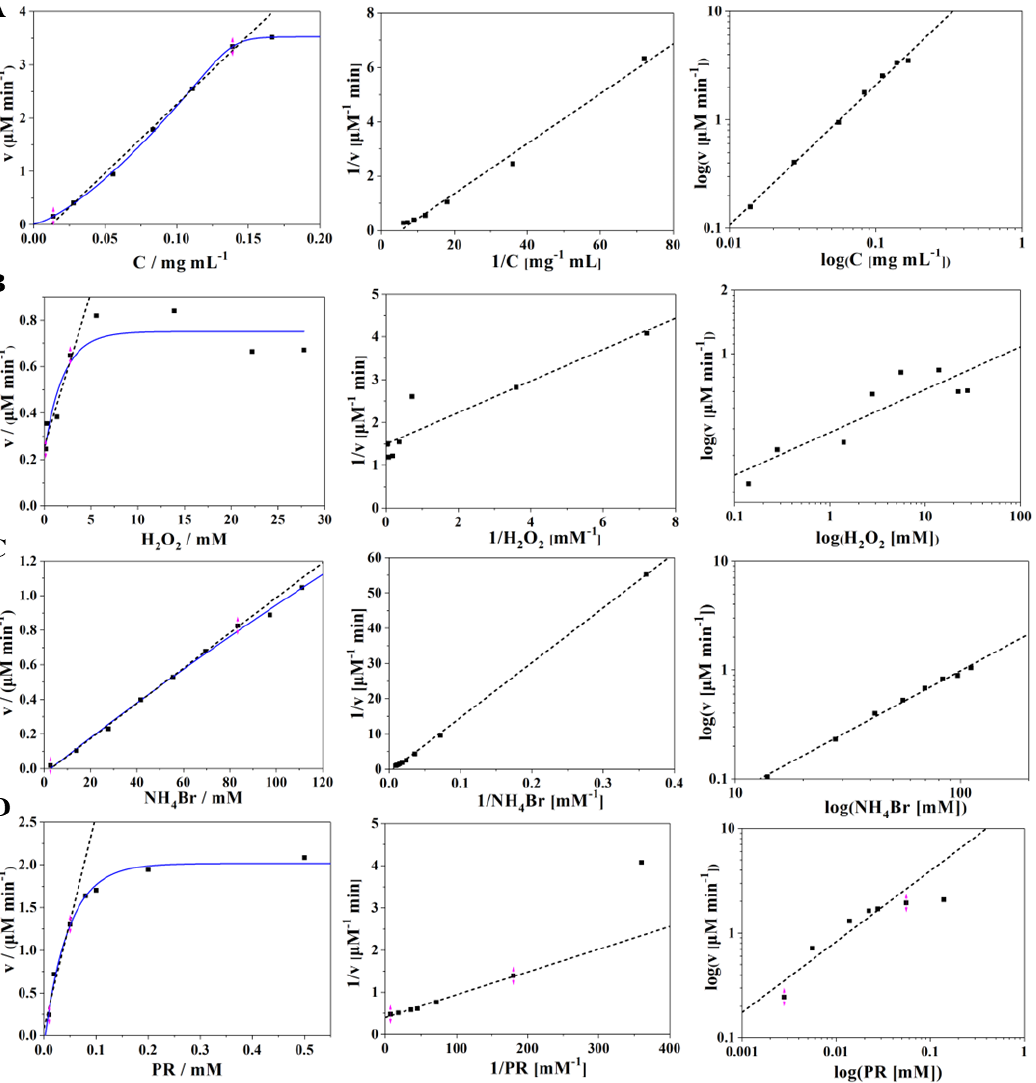
Figure 3. Kinetics of the fourfold oxidative bromination of PR as a function of the substrate concen- trations. The kinetics as a function of the substrate ( A ) C; ( B ) H 2 O 2 ; ( C ) NH 4 Br and ( D ) PR. Note: C represents the N-C/CeO 2 composite, blue line: nonlinearly fitted line of kinetic values, dark dashed line: the linearly fitted line of partial kinetic values, pink arrow: the fitting region.